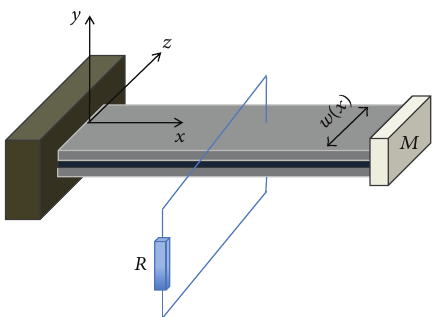
Figure 1: A bimorph piezoelectric energy harvester under clamped- free boundary